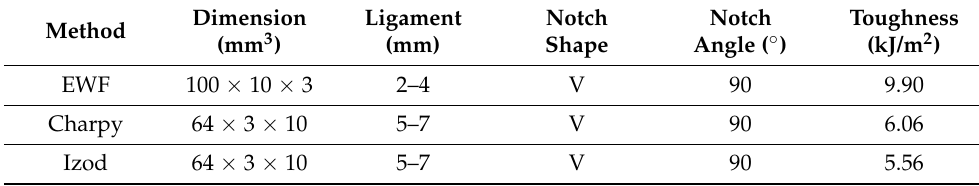
Table 2. PLA toughness using three